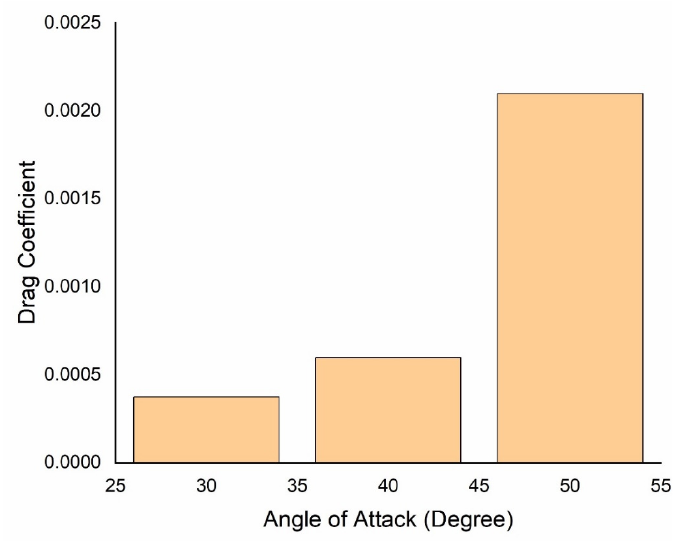
Figure 11. Simulated drag coefficient of bullet head (design II) at 30°,40°,and 50° angle of attack. Table 5. Simulated and experimental values of drag coefficient of design II of bullet heads at varying angles of attack.